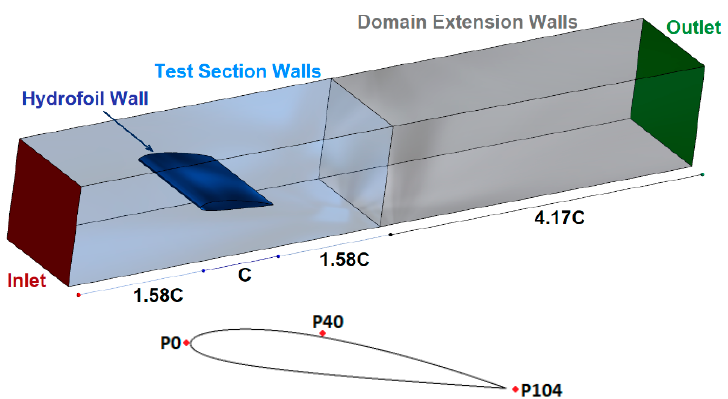
Figure 18. Computational domain and description of boundary conditions ( top left ) and position of pressure transducers at the symmetry plane ( bottom right ).